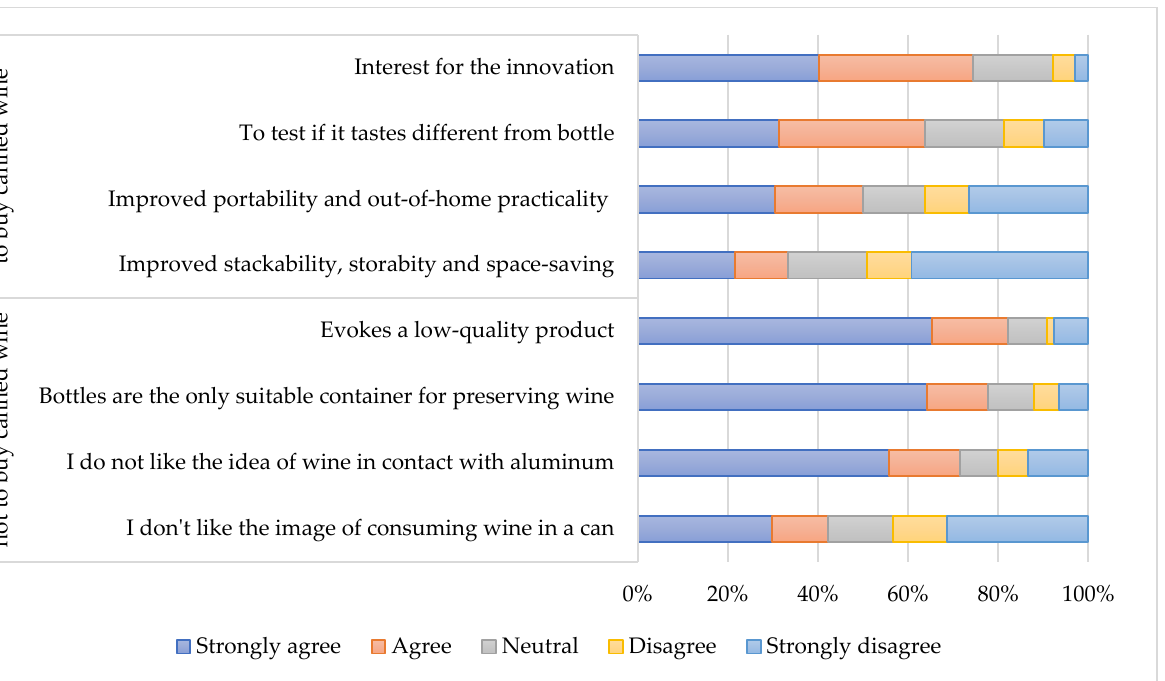
Figure 1. Main reasons related to the purchase ( n = 102) / non-purchase ( n = 449) of canned wine.